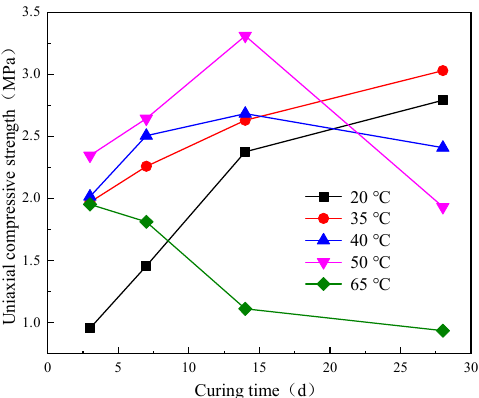
Figure 4. Variation of strength with curing time under different curing temperatures.